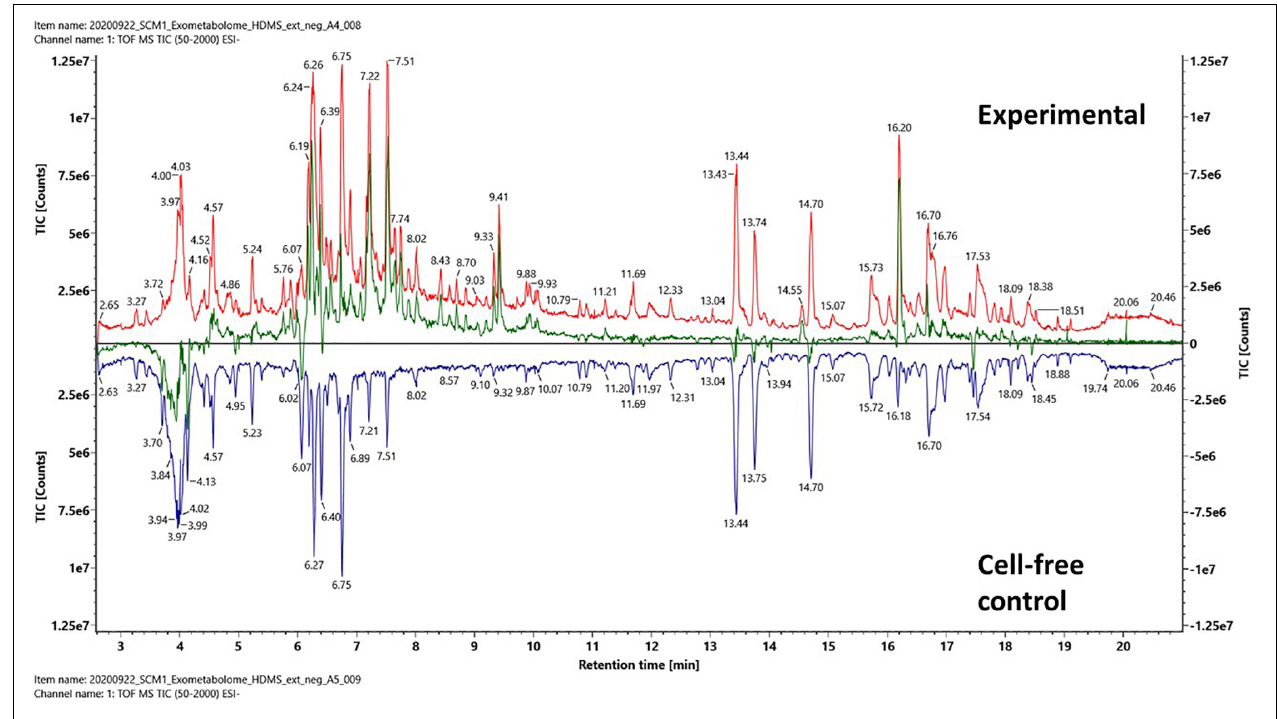
FIGURE 2 | Pairwise comparison analysis of the total ion chromatography (TIC) of an experimental culture medium (red) and a cell-free control culture medium (blue) after PPL-SPE extraction. The net spectrum between the experimental culture medium and cell-free control culture medium is shown as a subtracted chromatography (green) that represents the SPE retained fraction of the exometabolome of N. maritimus . Data were acquired in the negative ion